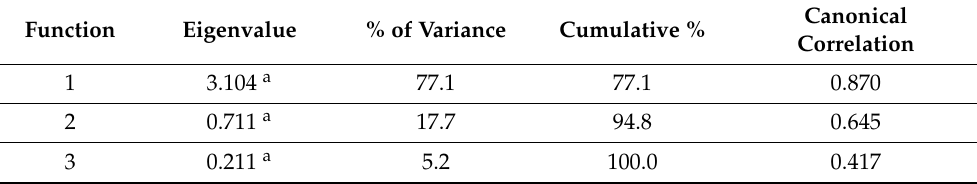
Table 3. Main parameters of DA.